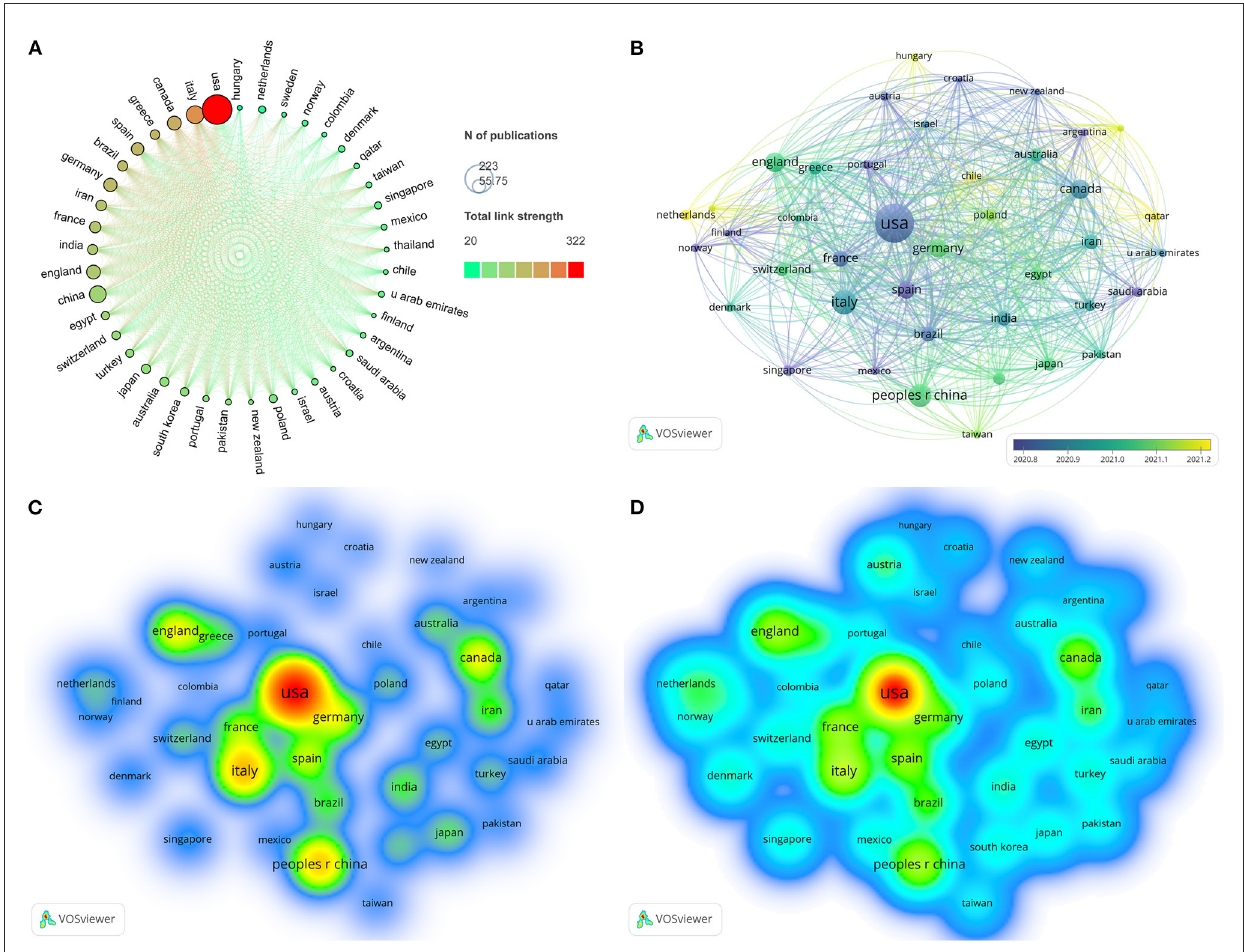
FIGURE2 Country/region co-authorship networks. (A) Scimago Graphica-generated chord diagram of country/region cooperation network ranked by total link strength. The size of the nodes represents the number of publications of each country/region, and the color of the nodes represents the intensity of cooperation between countries/regions. (B) Dynamics and trends of the countries/regions with five publications or more. The size of the nodes represents the number of publications, and the color depth of the nodes represents the average appearance year of the publication. (C) Density map of the number of publications of countries/regions generated by VOSviewer. Both the color and font size indicates the number of publications. (D) Density map of the frequency of citation of countries/regions generated by VOSviewer. Both the color and font size indicates the citation